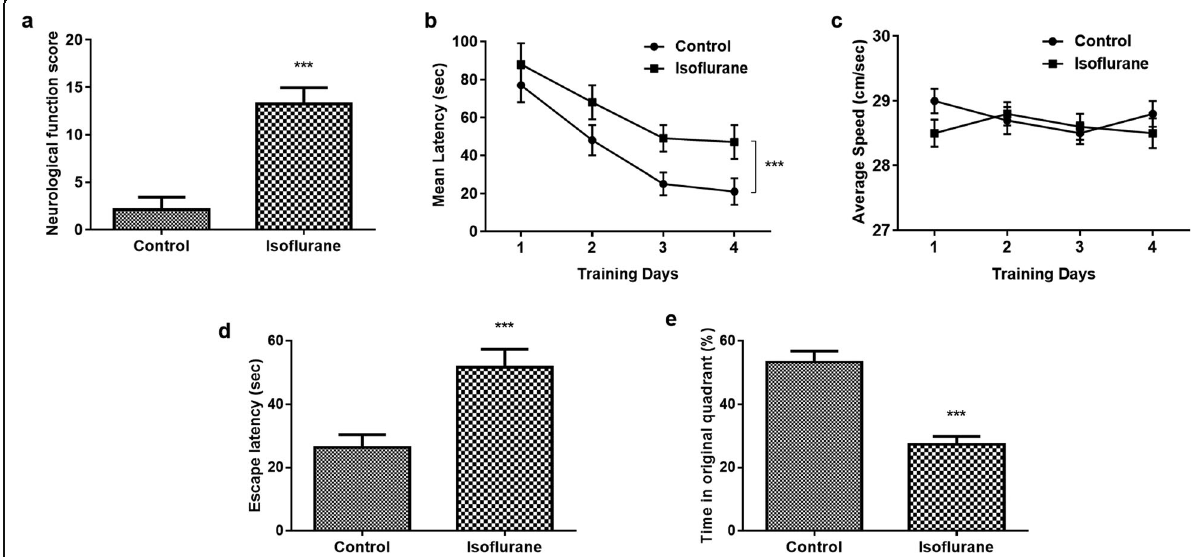
Fig. 1 Effects of isoflurane on neurological impairment in rats. a The neurological function score increased significantly in isoflurane treated rats compared with the control group. b During the spatial acquisition training time, the time required to locate the platform was significantly affected by isoflurane treatment compared with the control group. c Isoflurane treatment did not influence the swimming speed of rats during the spatial acquisition training time. d-e A probe trial was conducted to assess reference memory at the end of learning. Isoflurane treatment significantly enhanced the escape latency and reduced the time in the original quadrant of rats compared with the control group. *** P < 0.001